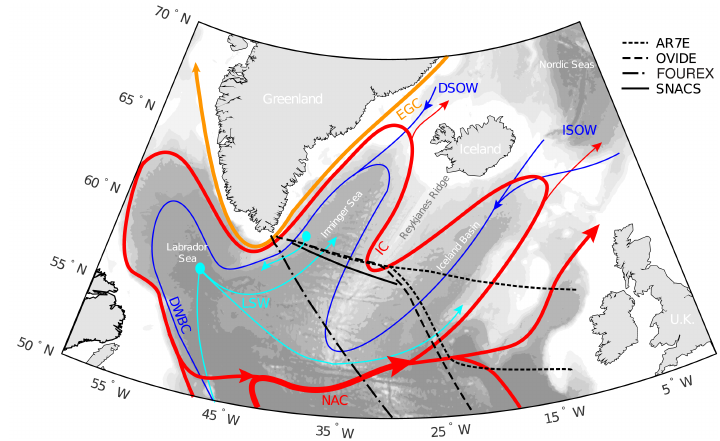
Figure 1. Schematic subpolar North Atlantic circulation. The location of the AR7E, OVIDE, FOUREX and SNACS lines are plotted in black on the bathymetry (500m intervals). The branches of the North Atlantic Current (NAC) turning into the Irminger Current (IC) are shown in red and the East Greenland Current (EGC) is plotted in orange. The dark blue currents illustrate the spreading of the Iceland–Scotland Overflow Water (ISOW) and the Denmark Strait Overflow Water (DSOW) at depth, which jointly with the Labrador Sea Water (LSW), in cyan, contribute to the Deep Western Boundary Current (DWBC). Adapted from Lherminier et al. (2010) and Pérez et al.